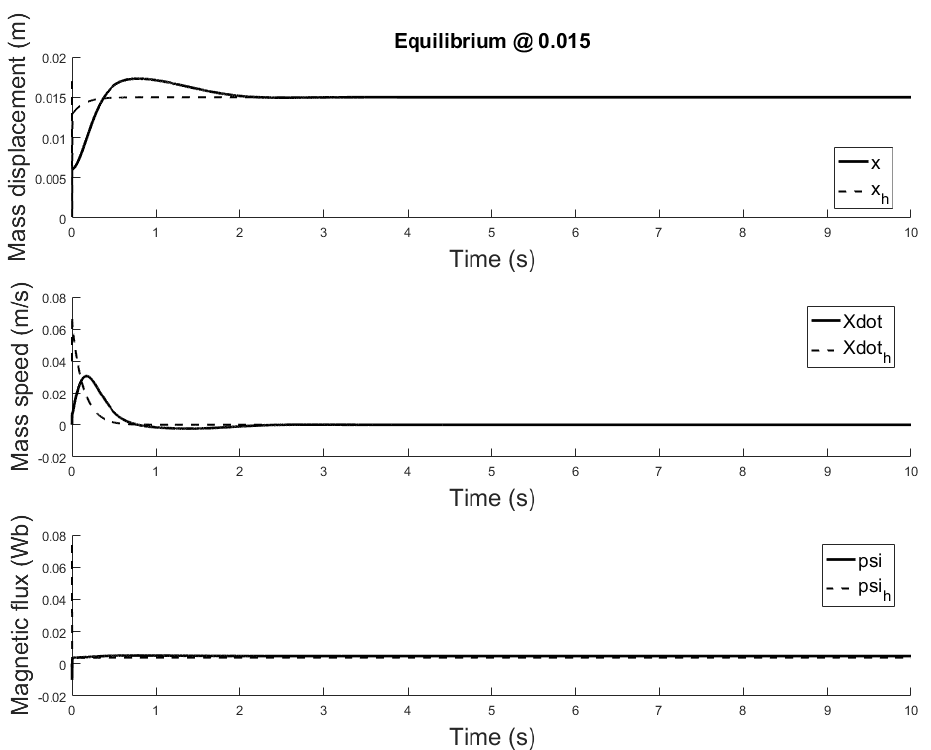
Figure 19. Observer and plant state estimates for initial conditions: x 0 = 0.006 m, ˆ x 0 = 0.001 m and . x 0 = 0 m/s, ˆ x 0 = 0.04 m/s and ψ = 0 Wb, ˆ ψ = 0.07 Wb, equilibrium at x = 0.015.